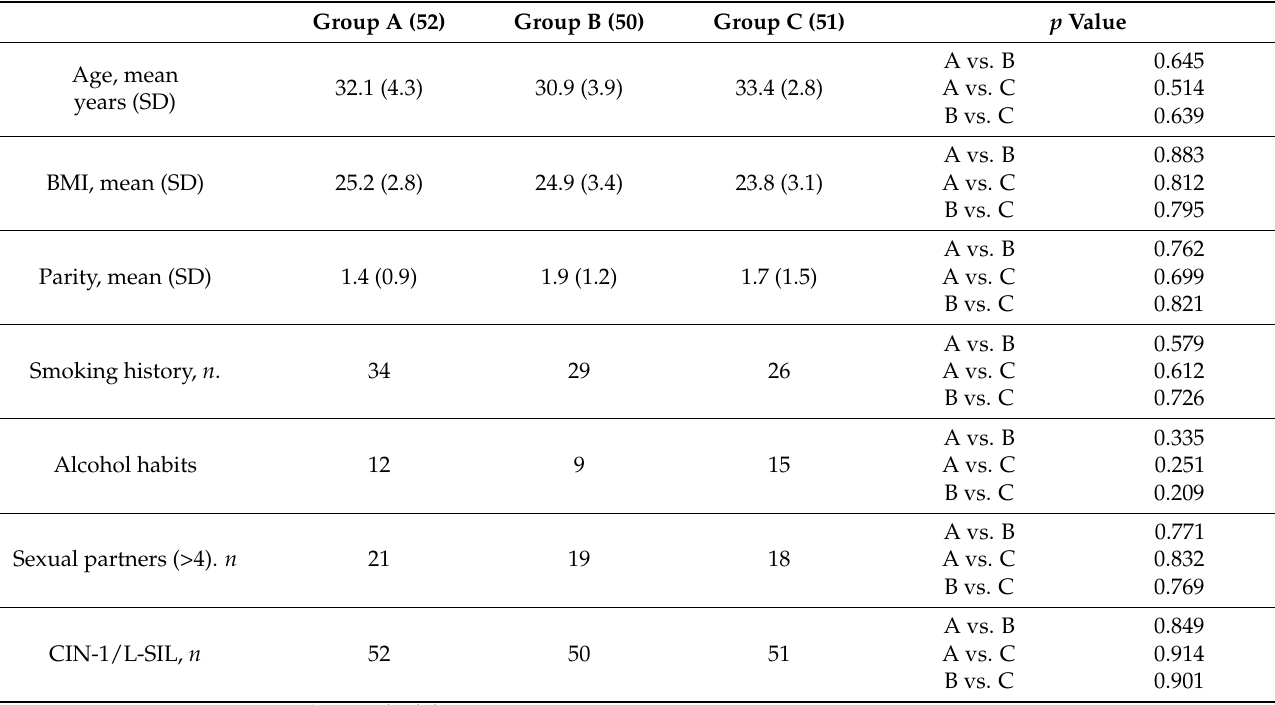
Table 1. Baseline characteristics of women included in treatment arms.